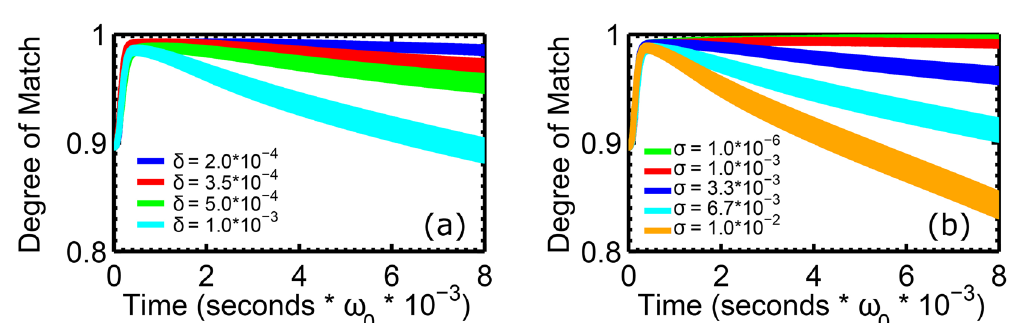
Figure 3. ( a ) Degree of match with the “a” pattern as the width of the uniform distribution from which oscillator frequencies are selected is widened. Stable phase locked synchronization does not occur, and the effect worsens with widening width (denoted in figure legend). ( b ) Plot of degree of match with the “a” pattern for uniform oscillator frequencies, but iterated σ (shown in the legend). Stability of the degree of match parameter is reasonable until σ = 3.3 × 10 − 3 . This is an order of magnitude larger than the typical value of δ that destroys effective synchronization, suggesting that the system is more robust under coupling strength dispersion than frequency dispersion. In both ( a ) and ( b ), the shown curves have been averaged across 100 independent simulations, and then subsequently over 100 time steps; larger oscillations in degree of match parameter for wider dispersion widths are still